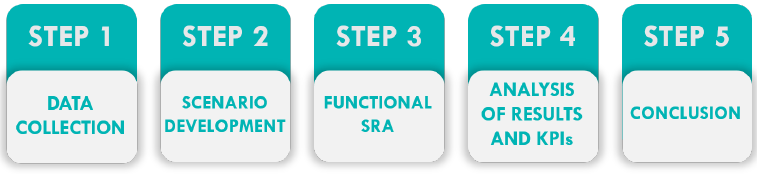
Figure 3. Functional-oriented